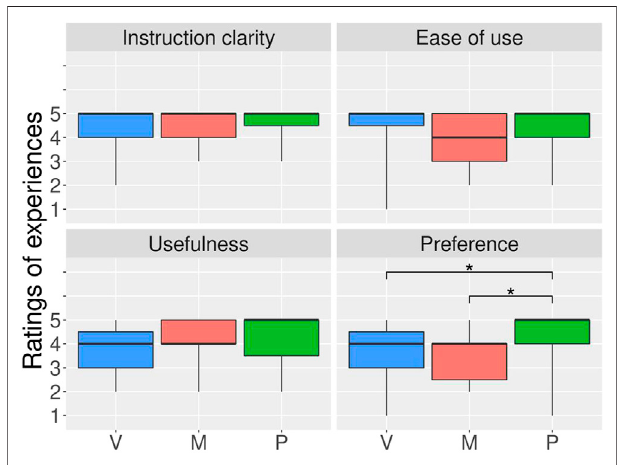
FIGURE 10 | Ratings of training experiences. *means signi fi cant difference ( p <